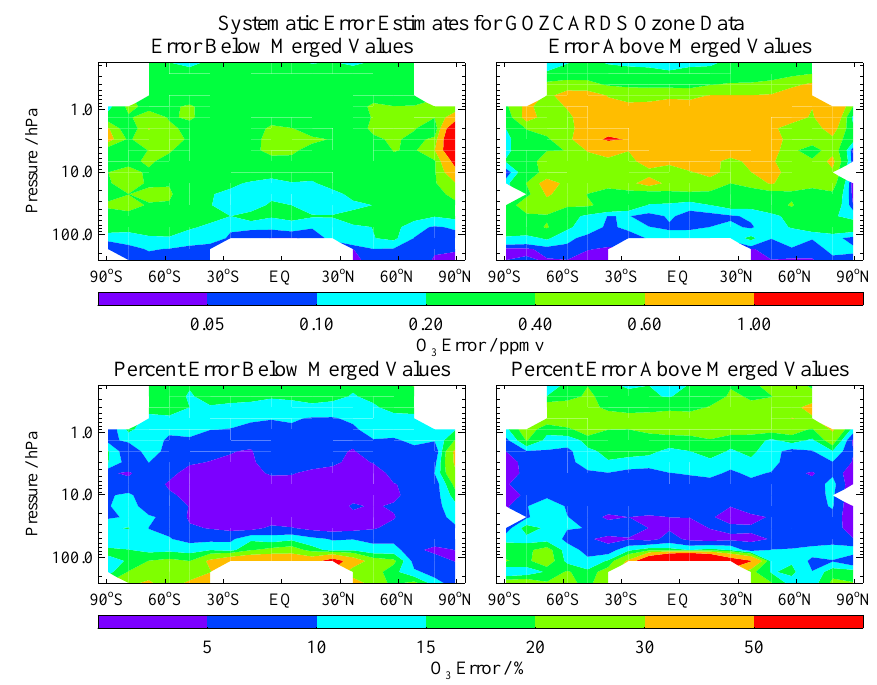
Figure 21. Systematic error estimates for GOZCARDS O 3 (similar to Fig. 6 for